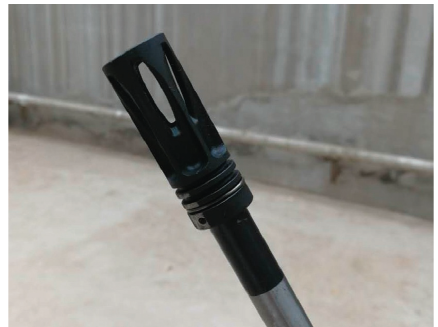
Figure 2: Experimental rifle with the muzzle